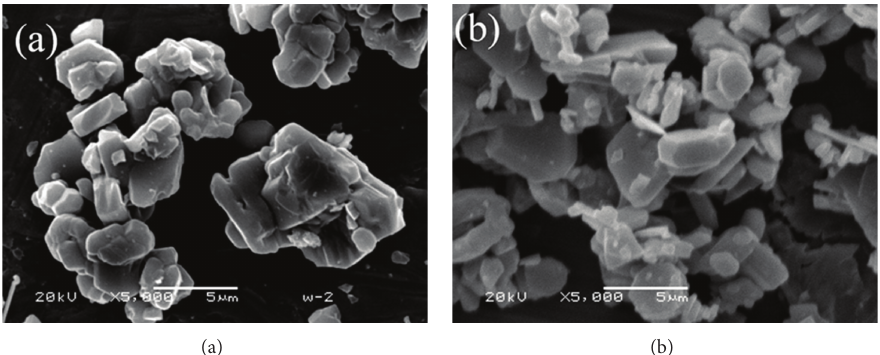
Figure 1: SEM images of (a) raw BAM and (b) 0.4 wt% CaF 2 -coated BAM.